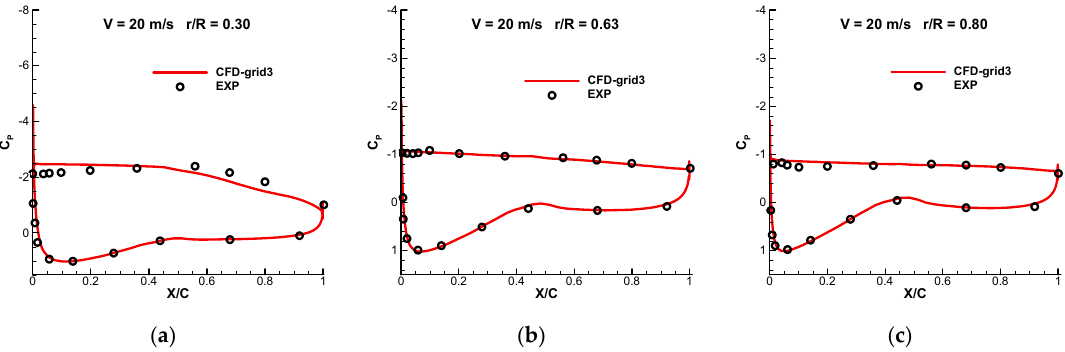
Figure 11. Comparison of pressure distributions between experimental data and present results (wind speed 10 m/s): ( a ) r/R = 0.30; ( b ) r/R = 0.63; ( c ) r/R = 0.80.